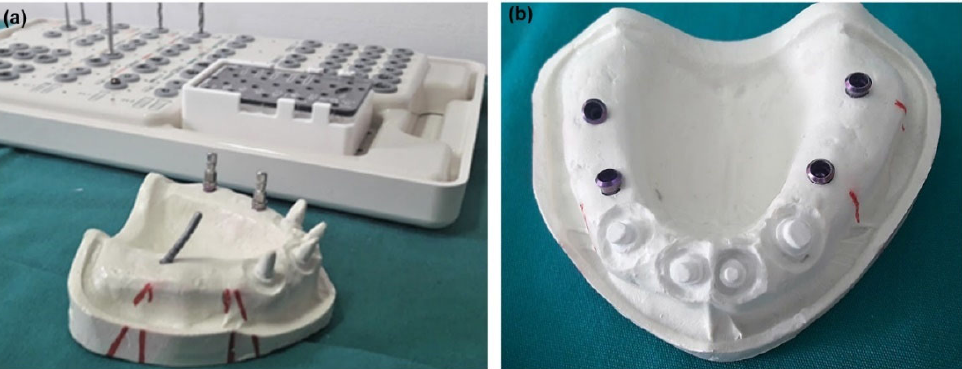
Figure 2. Showing ( a ) implant placement and ( b ) finished maxilla master model.